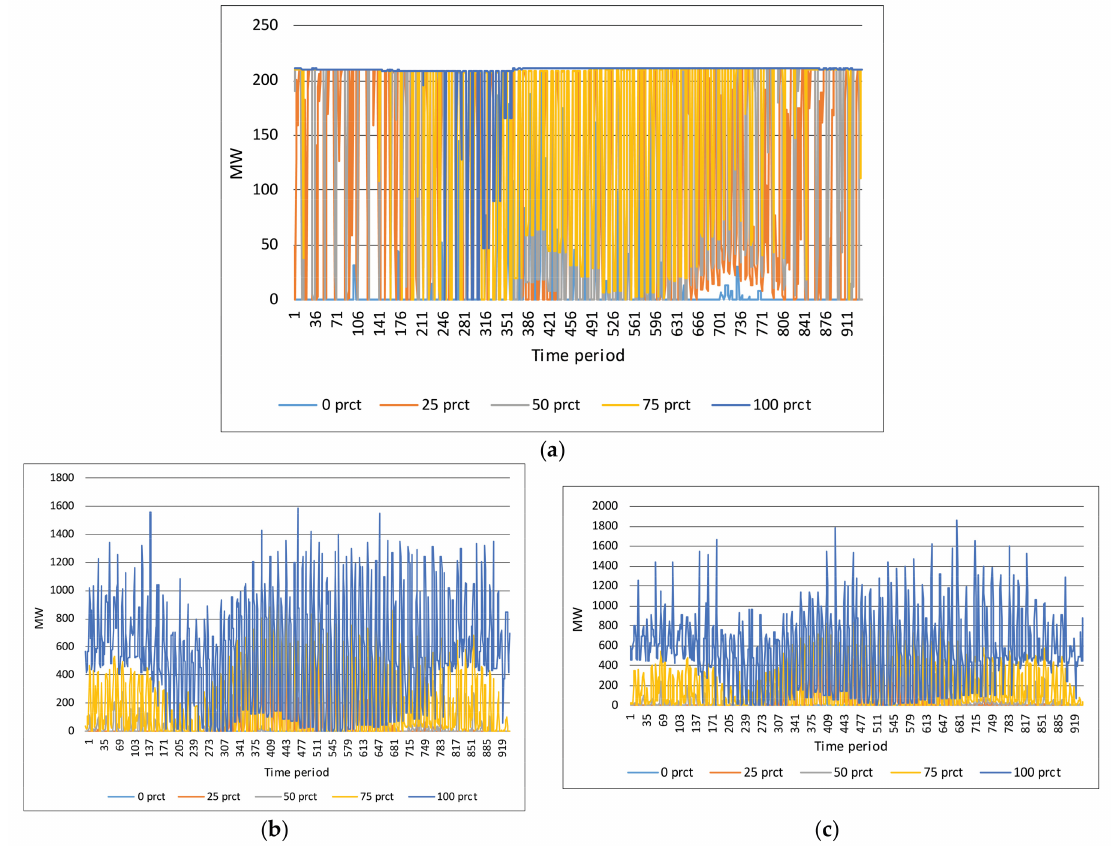
Figure 11. Percentiles (0, 25, 50, 75, 100) for production time step-by time step over the year for Lysebotn: ( a ) Present capacity 0.2 GW; ( b ) 1.4 GW extra capacity (11 GW in Norway); ( c ) 1.8 GW extra capacity (19 GW in